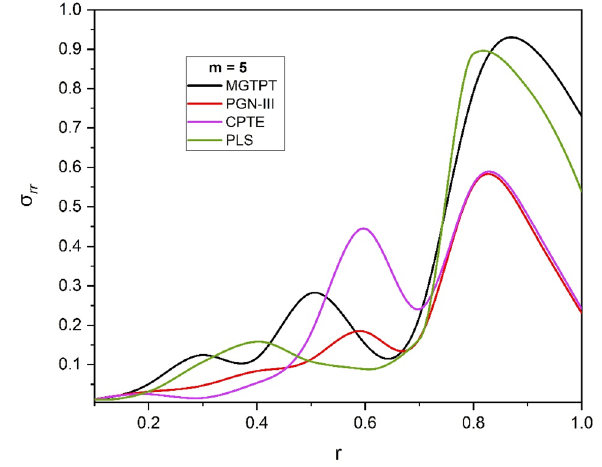
Fig. 8 The temperature change for different models